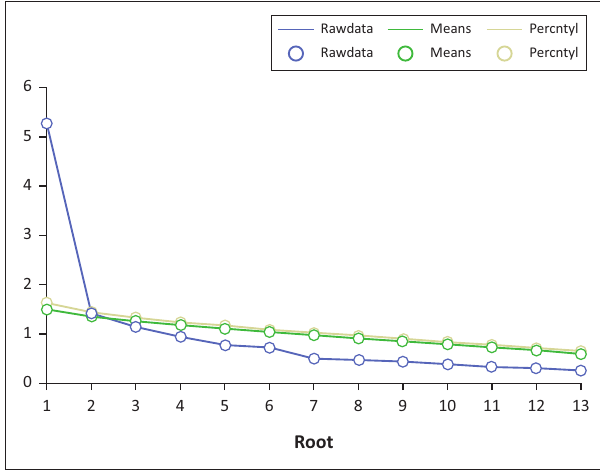
FIGURE 4: Tsplot for constructs in parallel